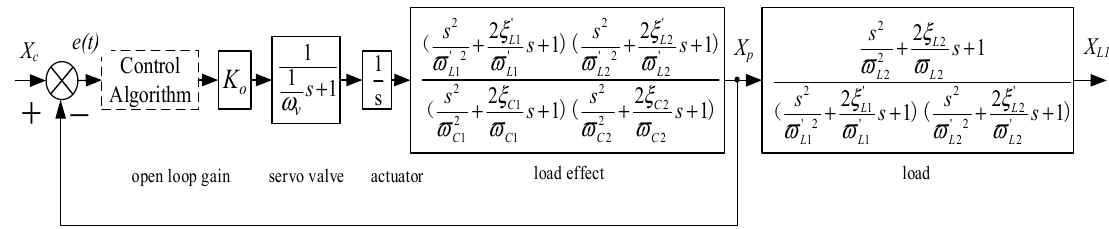
Figure 10. A normalized block diagram of the aerospace electro-hydraulic actuation system. The open-loop K o is represented in Equation (19).